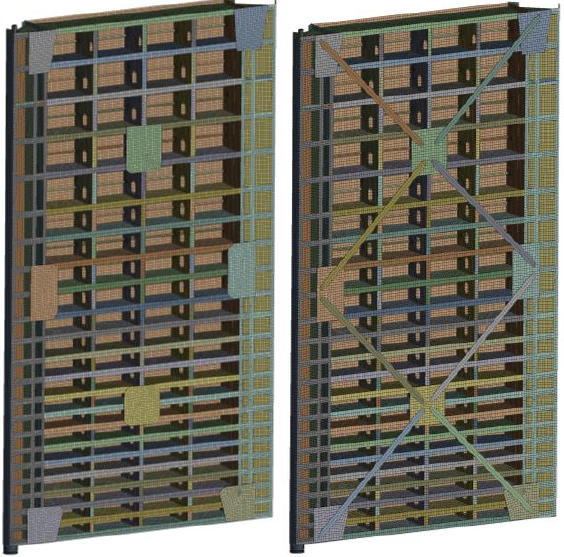
Figure 7. Finite element model of gate without and with back tie rods. Table 2. Stress load and constraint of the gate under different states.